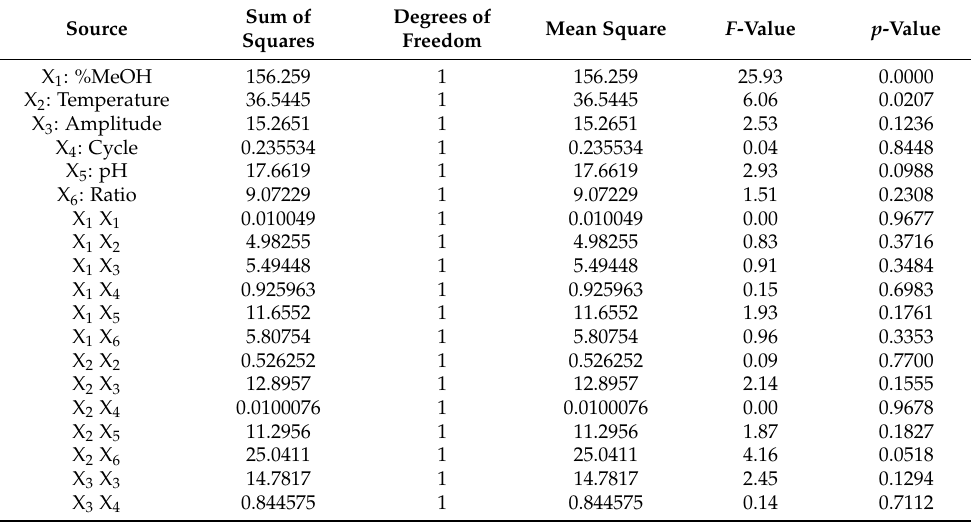
Table 3. Analysis of variance (ANOVA) of the quadratic model fitted to the TPC extraction